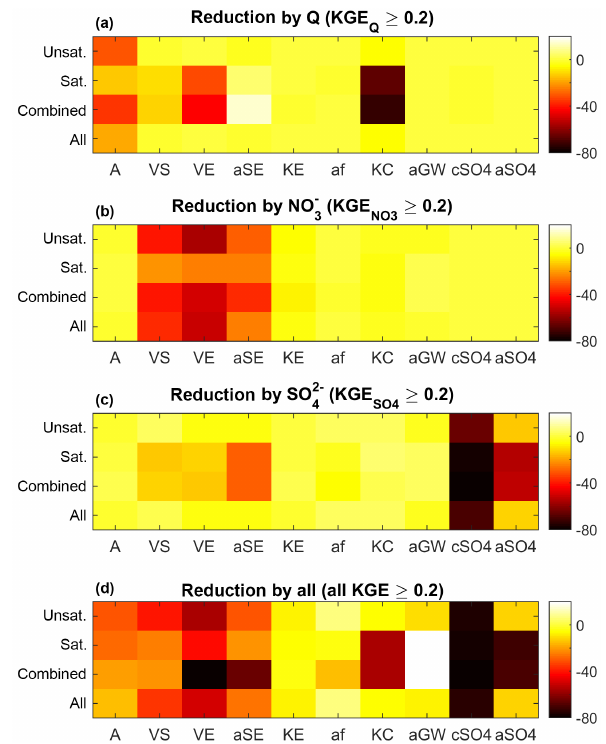
Figure 6. Change in distance between the 25th and 75th percentiles of each model parameter when the different soft rules are applied (top to bottom) for the four flow